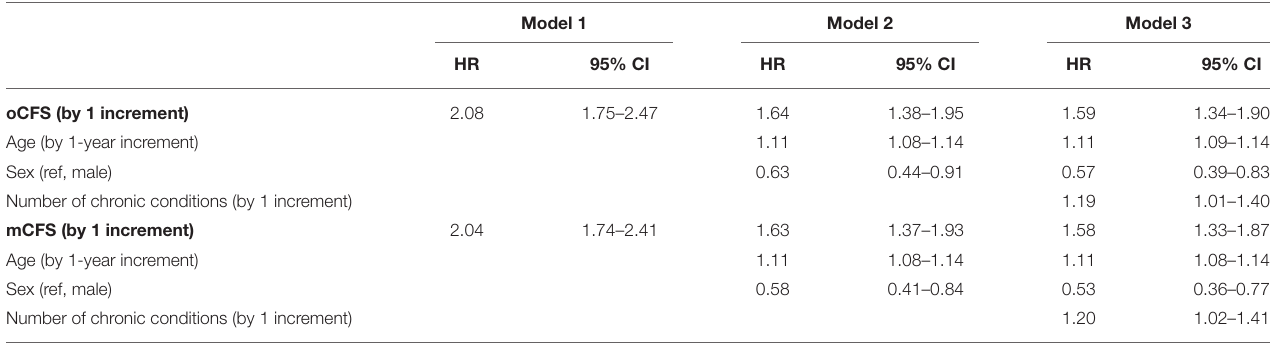
TABLE 2 | Increased risk of composite outcome according to Clinical Frailty Scale scores, by original classification tree (oCFS) and culturally modified classification tree